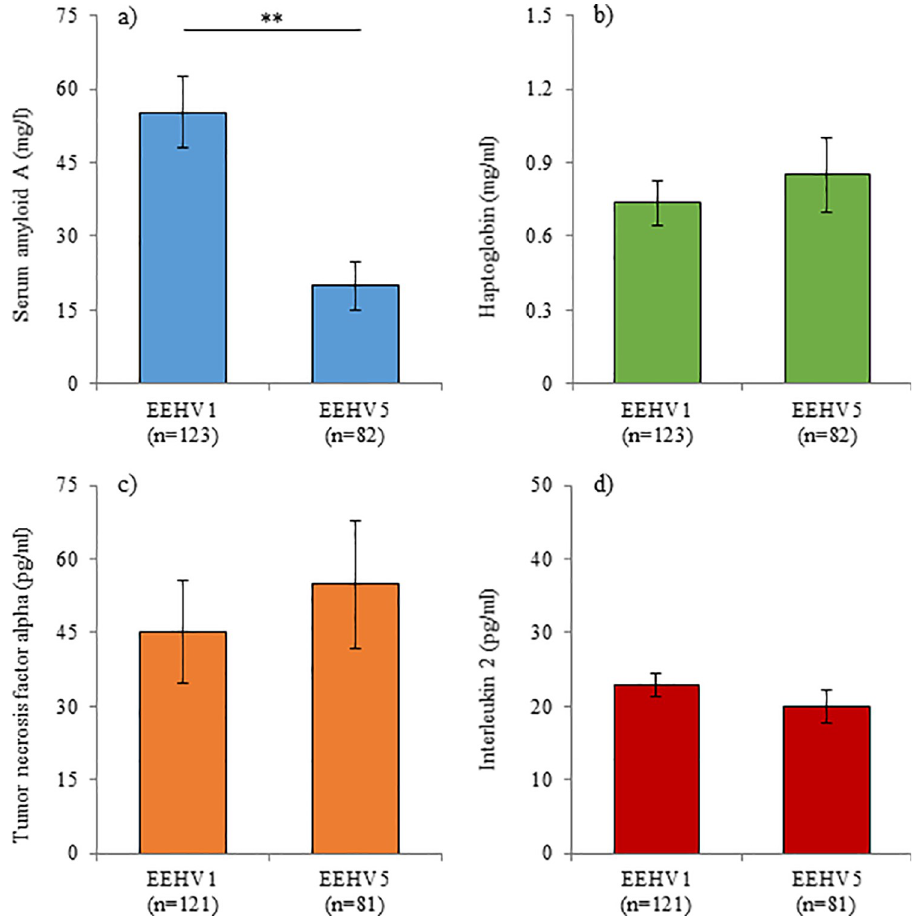
Fig 2. Acute phase protein and cytokine concentrations with EEHV1 or EEHV5. Serum concentrations of serum amyloid A (a), haptoglobin (b), tumor necrosis factor alpha (c) and interleukin 2 (d) on days when EEHV1 or EEHV5 was detected in whole blood by PCR. Bars represent the mean ± sem of the prediction from the GLMM; asterisks denote significant differences between categories ( �� P < 0.01; ��� P < 0.001).